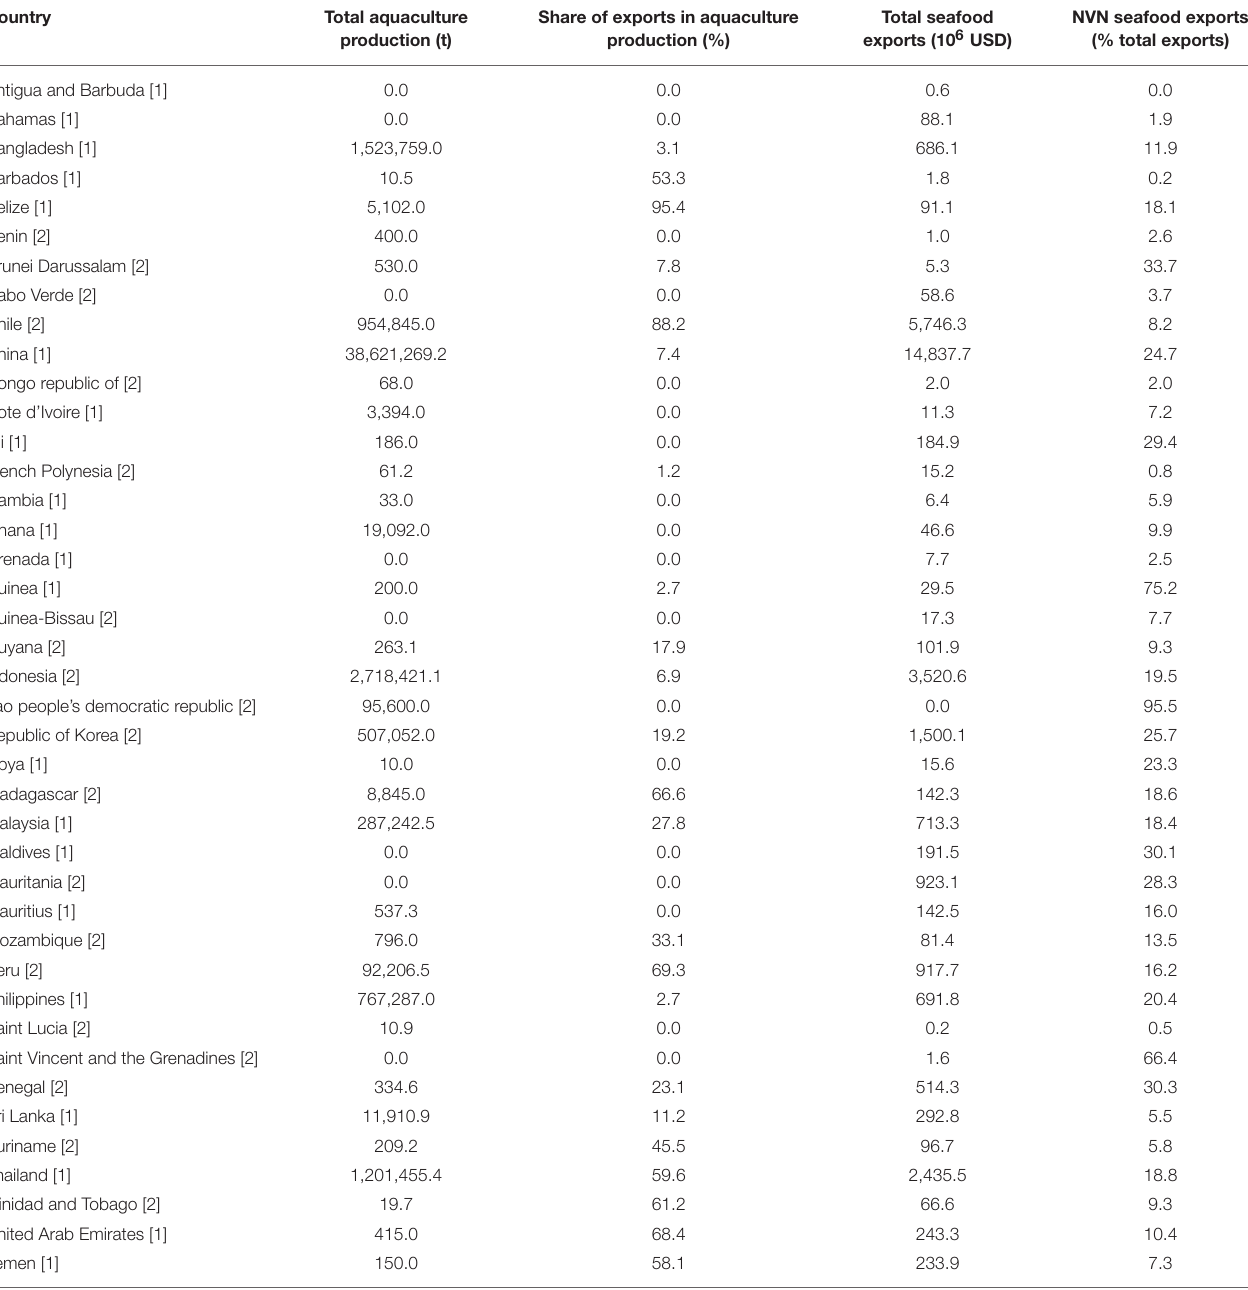
TABLE 1 | Total aquaculture production, aquaculture exports, total seafood exports, and percent of exports directed to nutritionally vulnerable nations (NVNs) from each NVN.